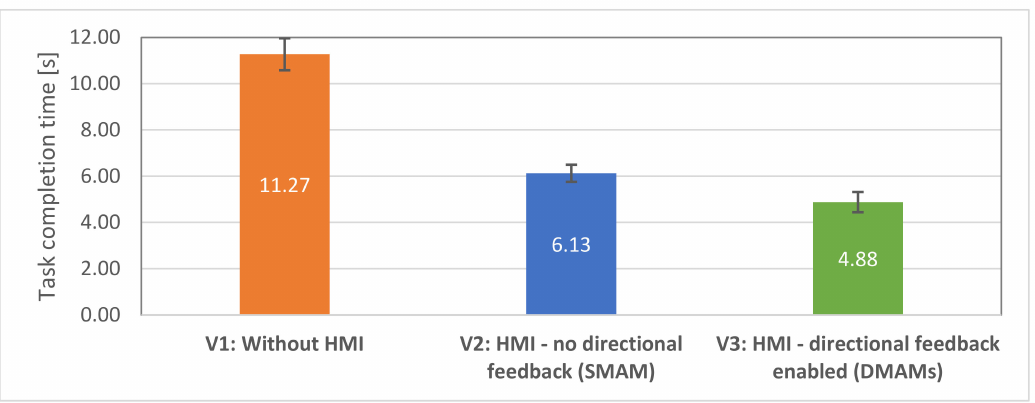
Figure 15. Average task completion time with standard errors for all 17 participants: lower is better.